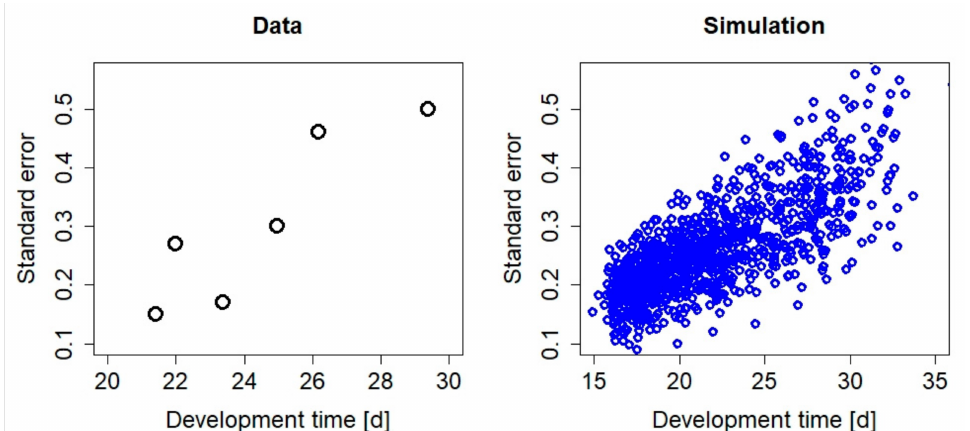
Figure 5. Standard error as function of development time in days (d). The data cover development times (larvae to adults), as measured by daSilva et al. [30], for different food types (soybean, cotton, maize, oats, wheat, and an artificial diet) at an ambient temperature of 25 ± 2 ◦ C. Simulated mean development times (first instar to pupation) and standard errors (n = 10) were calculated 1000 times for random values of the scaled functional response between f = 0.4 and f = 1 and temperatures in the range of 25 ± 2 ◦